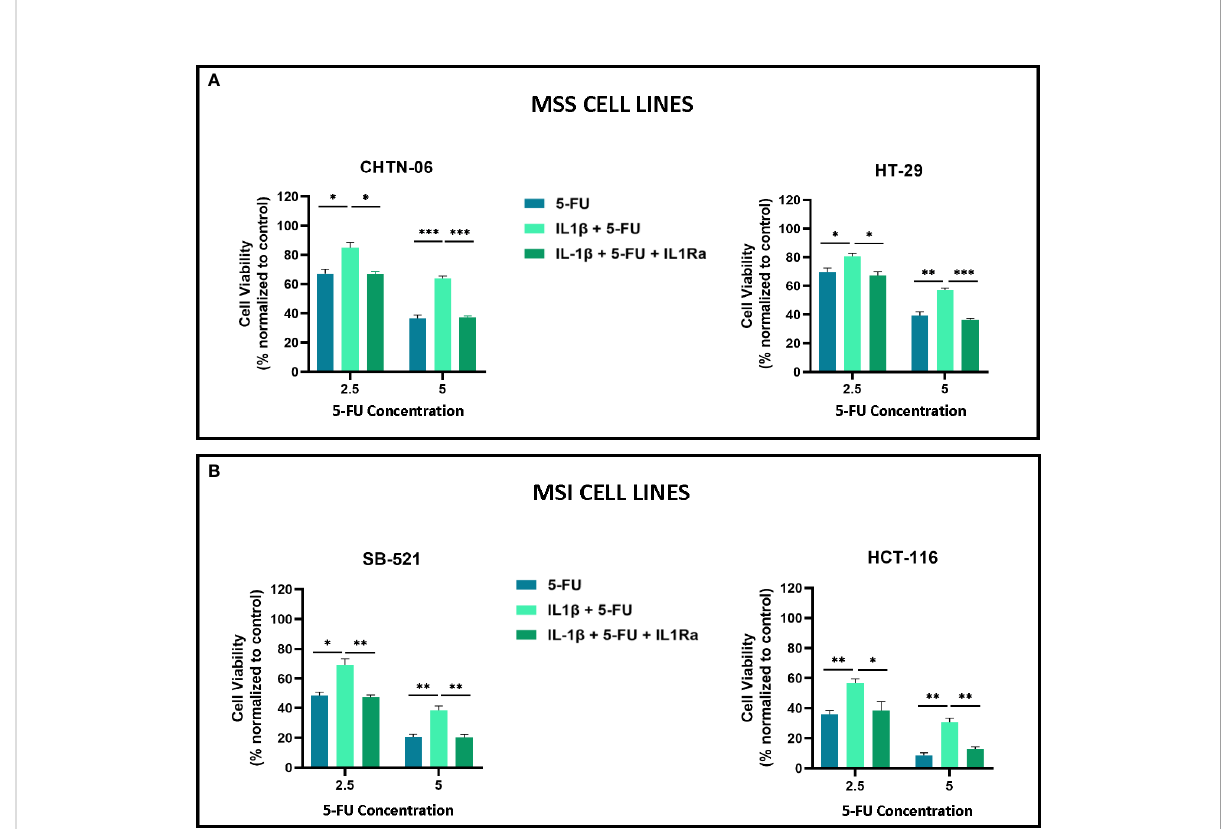
FIGURE 6 IL-1Ra counteracts IL-1 b effects on 5-FU sensitivity. Cell viability following treatment with 5-FU alone, in presence of IL-1 b , or in combination with IL-1Ra was determined by MTS assay. Cells were seeded in media, in the presence or absence of 10 ng/ml of IL-1 b and then treated with 5-FU alone or in combination with IL-1Ra, and incubated for 72 hours. (A) MSS cell lines CHTN-06 and HT-29; (B) MSI cell lines SB-521 and HCT-116. Data are representative of three independent experiments. Error bars represent SEM. *p<0.05, **p<0.01,